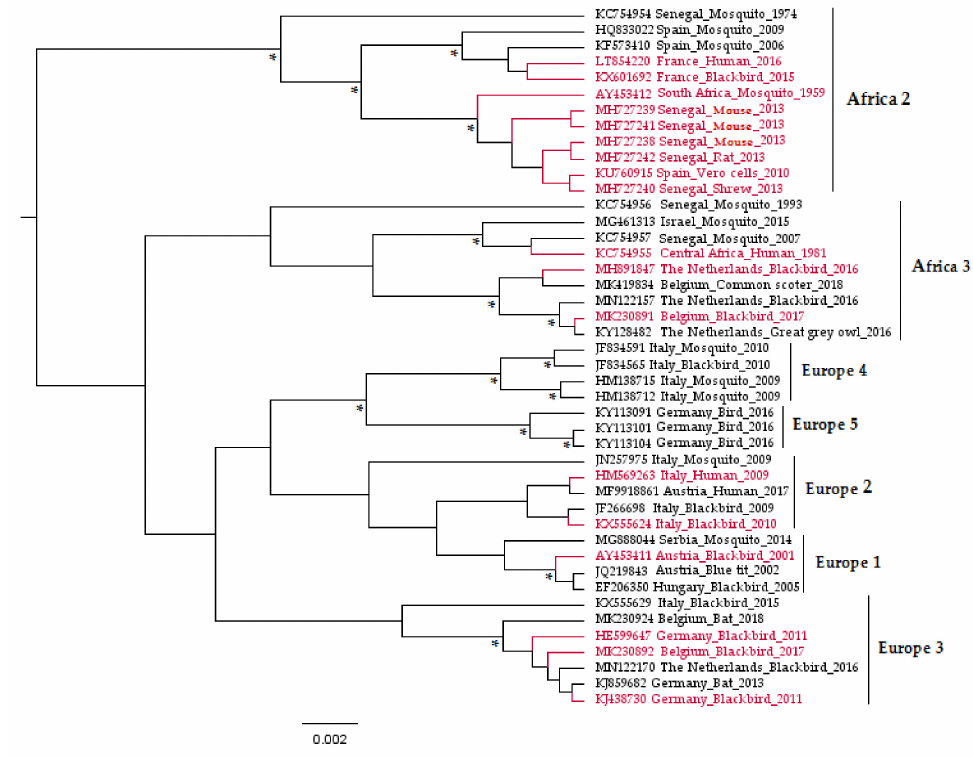
Figure 1. Phylogenetic tree representing the placement of Usutu virus (USUV) strains used to infect experimental models in vitro and in vivo based on partial non-structural 5 genes. The asterisks (*) indicate a support value from Bayesian posterior probabilities > 70%. To improve visualization, Africa 1 lineage (KC754958 Central African Republic_Mosquito_1969) is not represented in the figure, and phylogenetic positions of USUV experimentally used in the laboratory are red-colored. Taxon information includes the GenBank accession number, country, and host in which the virus was detected and detection year. The scale bar indicates the mean number of nucleotide substitutions per